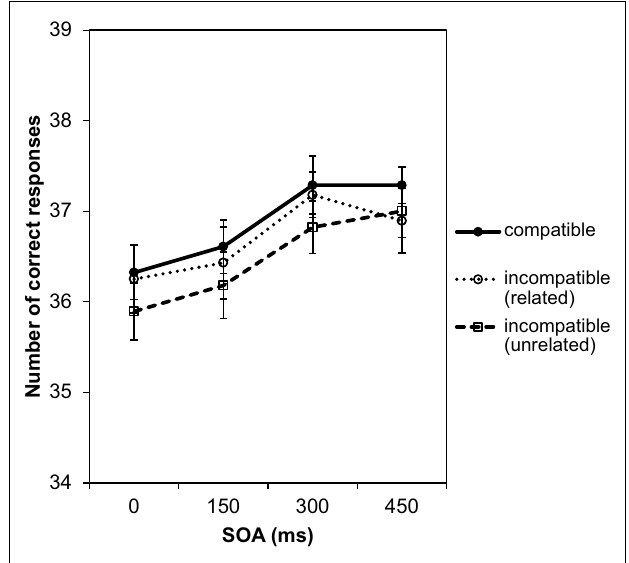
FIGURE 6 | Number of correct responses depending on SOA and compatibility. The maximum number of correct responses for each experimental condition was 40. In counting correct responses, erroneous responses and slow responses with RTs over 2000ms were excluded.